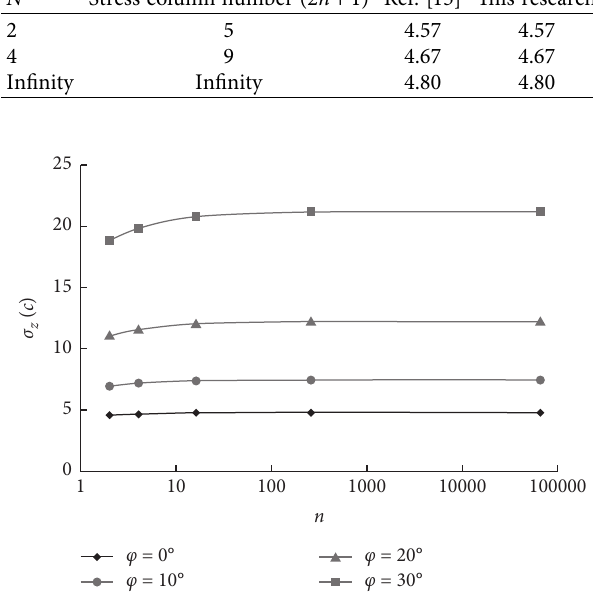
Figure 7: The correlation of bearing capacity and stress column amount.